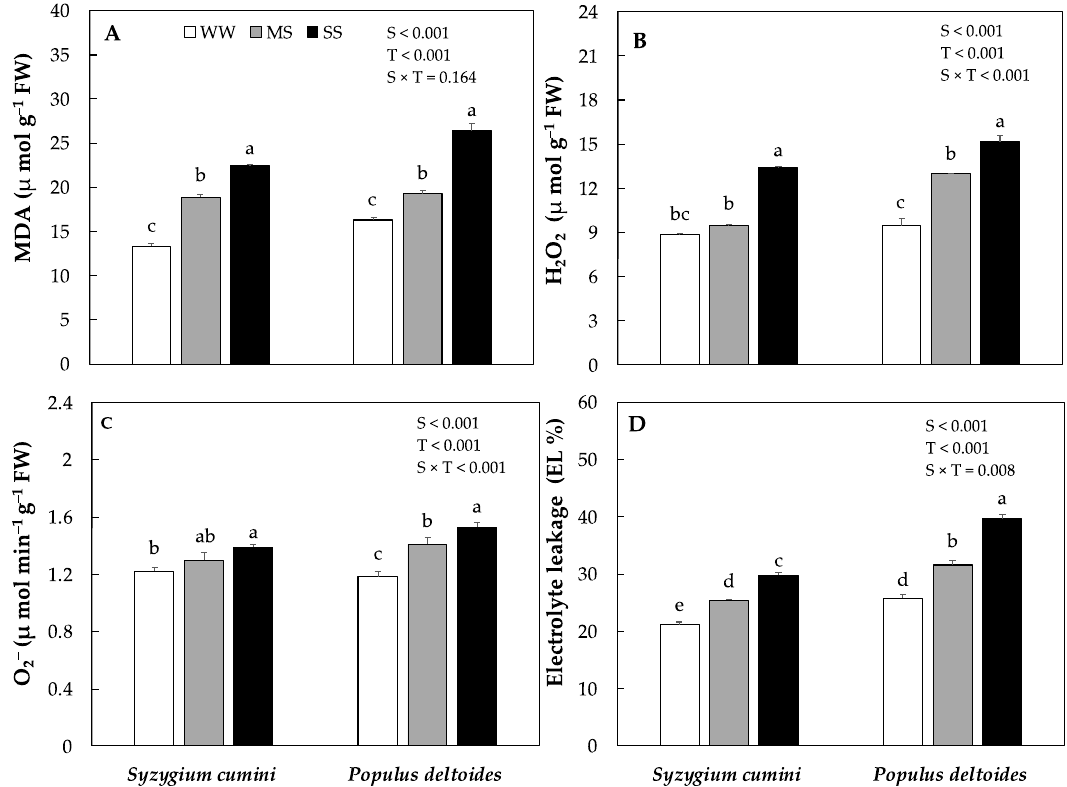
Figure 3. Concentration of malondialdehyde contents, MDA, ( A ), various oxidants such as hydrogen peroxide, H 2 O 2 ( B ), and superoxide radical O 2 ‐ ( C ), along with Electrolyte leakage, EL% ( D ) under various level of water deficit treatments in Syzygium cumini and Populus deltoides . The traits were tested using a two ‐ way ANOVA for species effect (S ‐ effects), treatment effect (T ‐ effects) and interaction effects (S × T). Values represent the means (±SE) in various treatments. Small letters represent significant difference between treatments within each species tested using the Dunnett’s test. All tests were taken to be significant at p < 0.05.